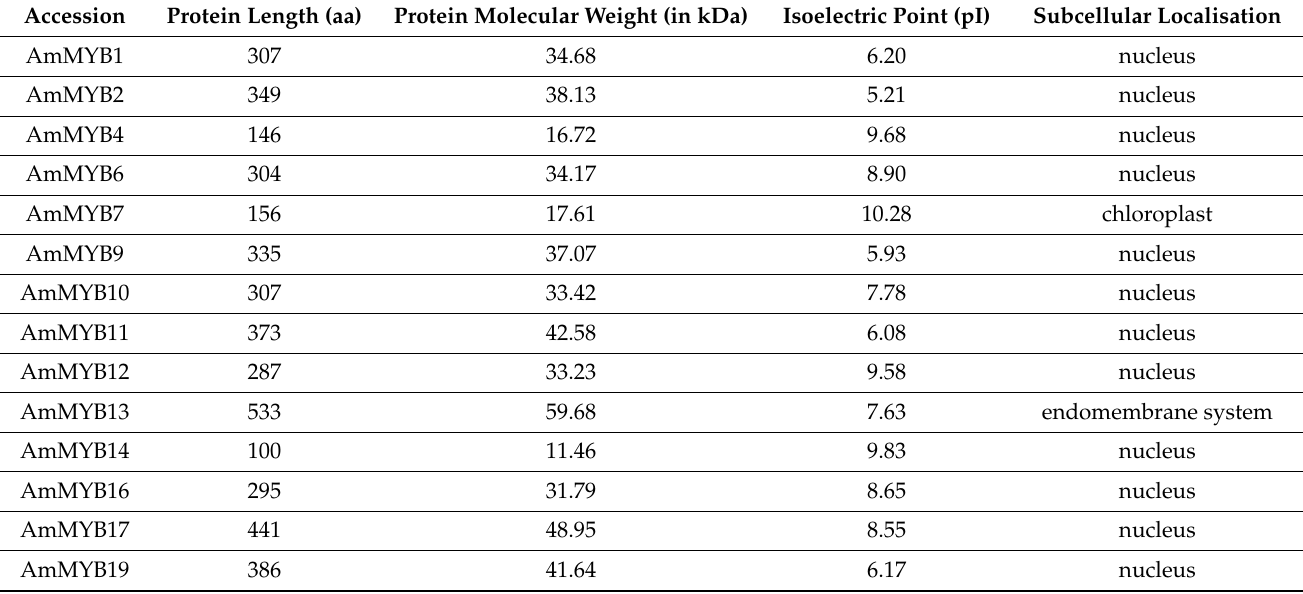
Table 1. The length distribution and chemical properties of Am R2R3 MYB